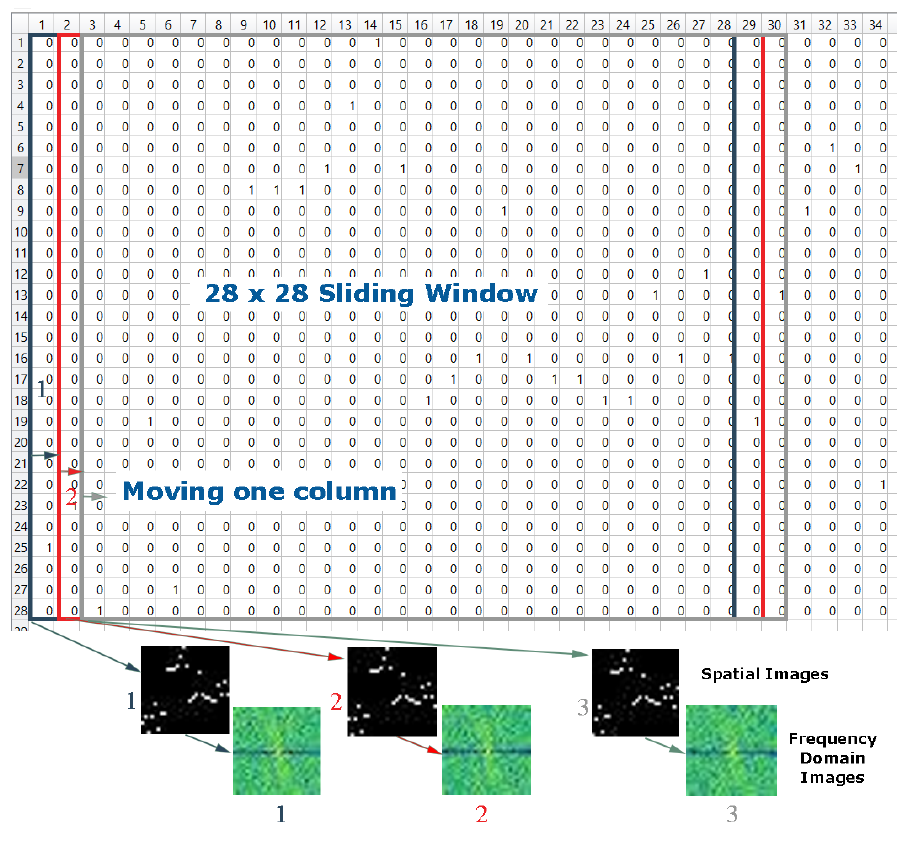
Figure 2. Sliding window of size 28 with overlapping by one